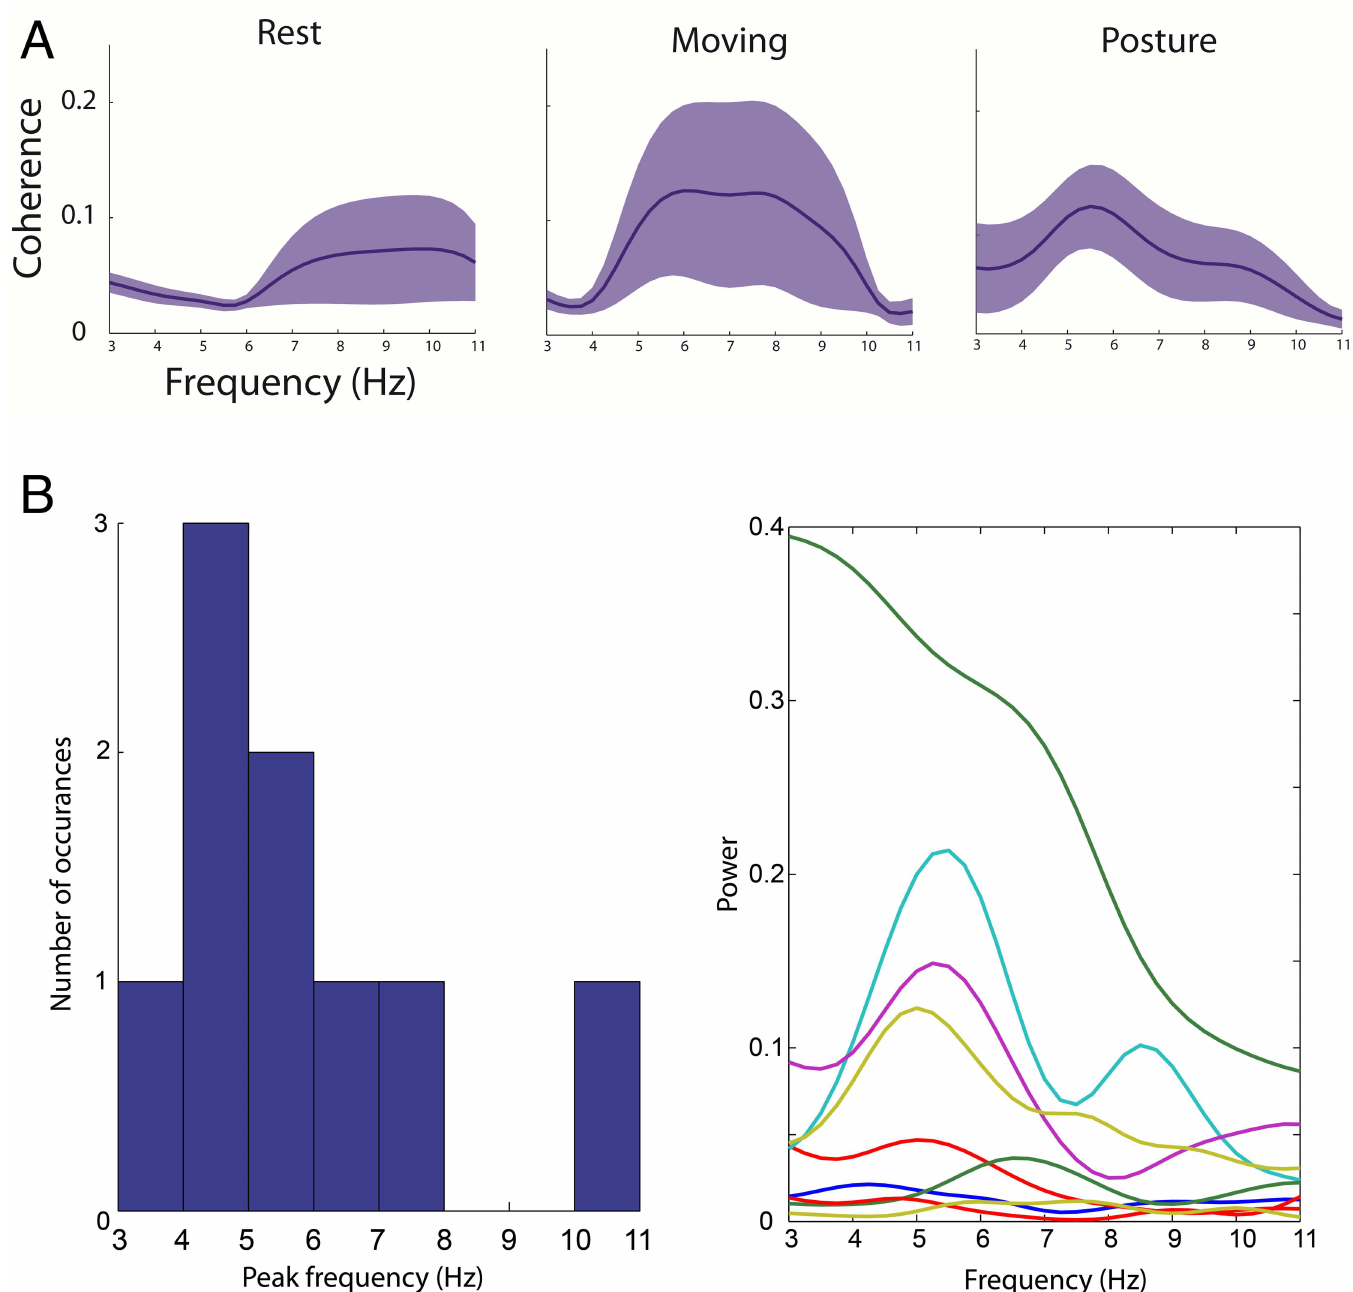
Fig 3. The EMG and LFP data over epochs. (A) The data for each of the patients was first split into different behavioural epochs: rest, when the patient was asked to refrain from moving (seven patients, 14 spectra); moving,when the patient was asked to make self-pacedrepetitive movements such as opening and closingthe hand (five patients, nine spectra); and posture, when the patient was asked to hold their arm out (three patients, four spectra). We can see that in all epochs there is an increasein tremor-bandcoherence, with a more tuned increase in the moving and posture conditions. (B) In additionto the mean cross coherence, in order to further demonstrate the variabilityacross patients, we show the cross-coherence for the posture epochfor all nine spectra and a histogramsummarisingthe peaks of the cross-coherence spectra in the 3–11 Hz range.